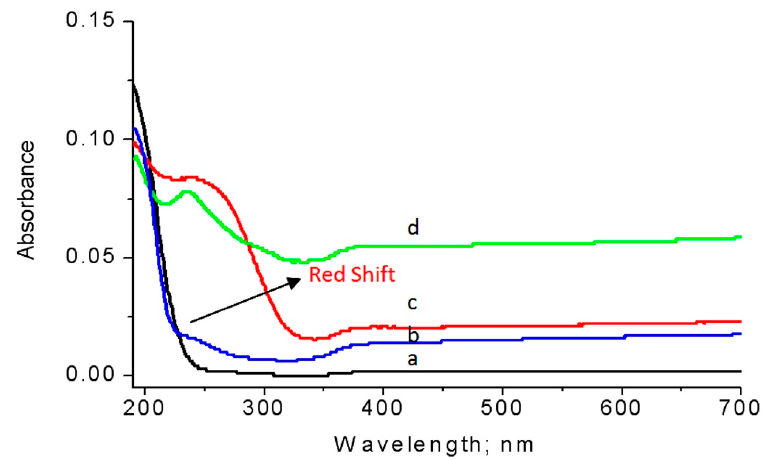
Figure 10. Absorbance spectra of ( a ) Zn-Al LDH, ( b ) Zn-Al-GO1, ( c ) Zn-Al-GO2, and ( d ) Zn-Al-GO3. The energy of photon (E) = h ν , the absorption coefficient is the value of Abs, and the energy band gap is E g . The term (n), which denotes the nature of the transitions, = 2 for direct transition. By plotting (Abs.E) 2 versus energy of photon (E), the band gap energy is determined through the tangent drawn to the curve intersect the energy axis at 0. Figures 11 and 12 show the Tauc plots of Zn-Al LDH, Zn-Al-GO1, Zn-Al-GO2 and Zn-Al-GO3 for direct transition. In Figure 11a, the estimated direct band gap energy of Zn-Al LDHs was found to be 5.5 eV. By combining graphene oxide with Zn-Al LDHs, the band gap energy decreased to lower values. The band gap energy became 2.5 eV after doping with the lower percentage of graphene oxide as shown in Figure 11b. It means that Zn-Al-GO1 is a suitable material to act in sun light. By increasing the content of graphene oxide, the band gap energy decreased from 5.5 eV to be 4.0 eV as shown in Figure 12. These results indicated that narrowing of band gap energy of Zn-Al LDHs (red shift) was observed through doping with graphene oxide. In addition, it concluded that 1.3% of graphene oxide was the optimum percentage for converting Zn-Al LDHs to become photo-active in the visible region. The high narrowing of the band gap of Zn-Al-GO1 may be explained according to many body effects of graphene nanosheets on the conduction and the valence bands. This phenomenon which affects the optical absorption edge with increasing the donor density is due to many body effects such as exchange energy due to electron–electron and electron– impurity interactions. In the other composites, the high percentage of graphene can cause blocking for lowest states in the conduction band because of aggregations of graphene sheets [46]. Figure 11. Band gap energy of ( a ) Zn-Al LDH, and ( b ) Zn-Al-GO1.